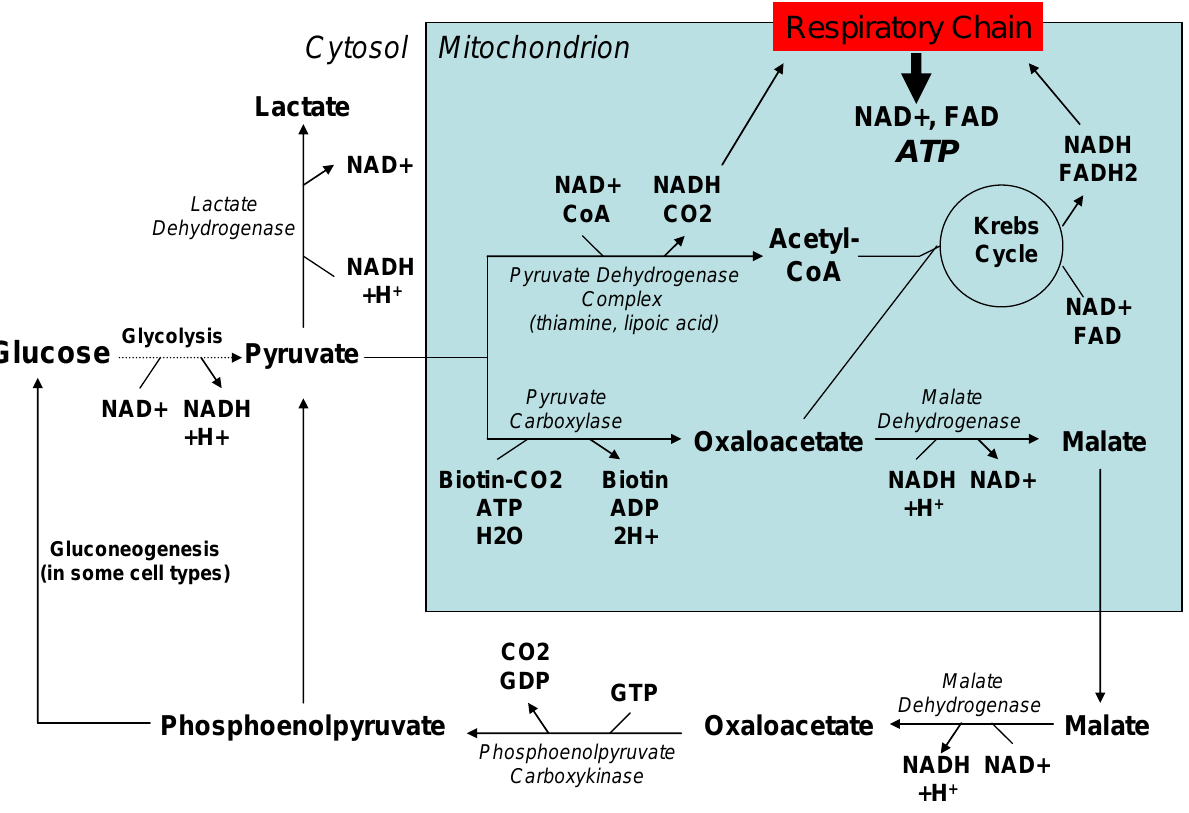
Figure 1. An integrated view of pathways involved in cell energy